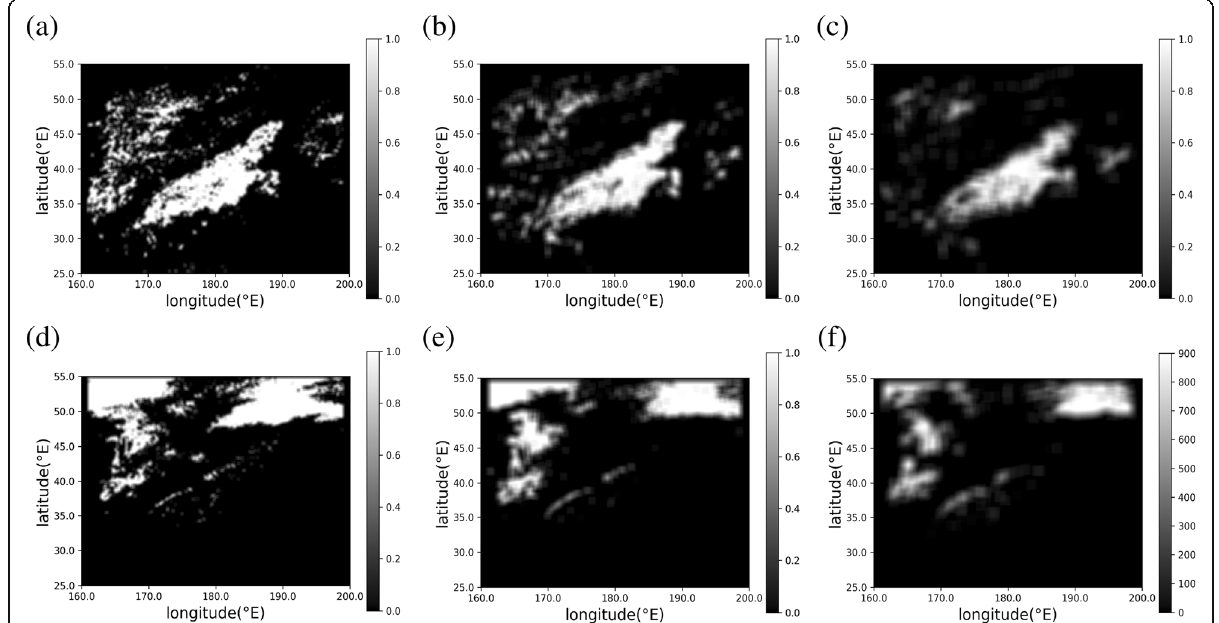
Fig. 2 Examples of probability images in the cases of N = 10, 20, and 30 derived from Fig. 1b. a , b , and c are probability images for dust storm in the three cases, respectively. d , e , and f are those for